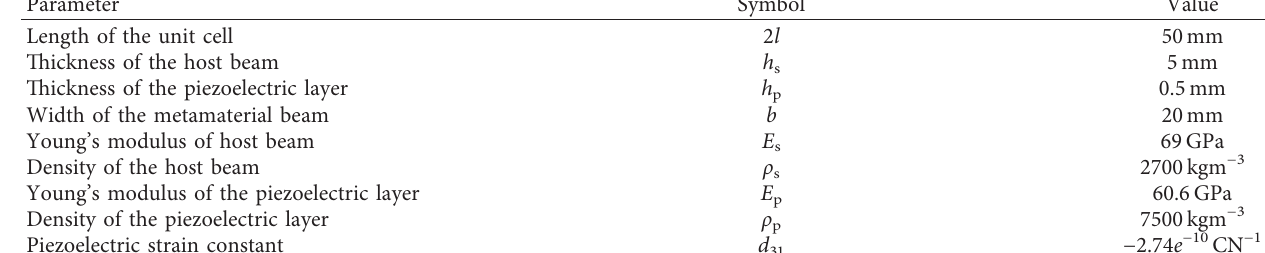
Table 1: Parameters of the metamaterial beam.